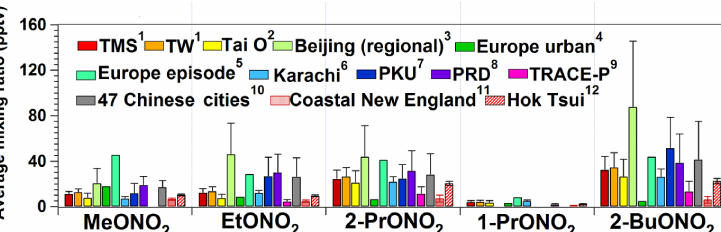
Figure 2. Comparison of alkyl nitrate mixing ratios in different locations. Data collected by UCI before 2008 (PRD and TRACE-P) were adjusted to UCI’s new calibration scale to permit direct comparison (see text for details about the new calibration). 1 – this study,